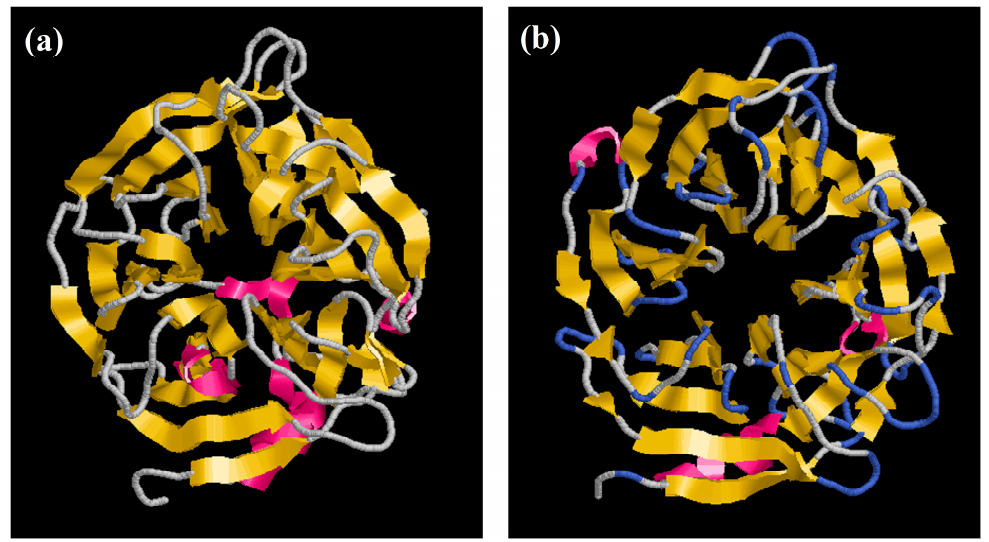
Figure 6. Homology modeling of phytase enzyme PhyRC001. ( a ) B. subtilis phytase model (3AMR, chain A); and ( b ) PhyRC001 phytase model. chain A); and ( b ) PhyRC001 phytase model.